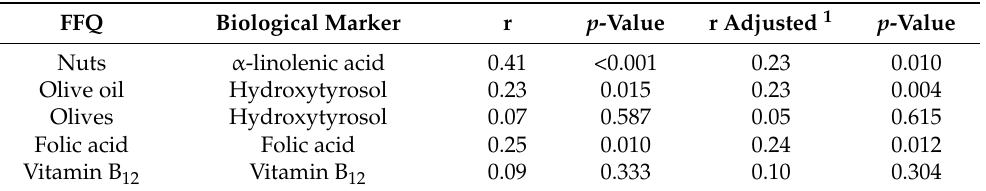
Table 5. Pearson correlations (r) between biological markers and related nutrient or food intake derived by the food frequency questionnaire (FFQ) ( n = 109).